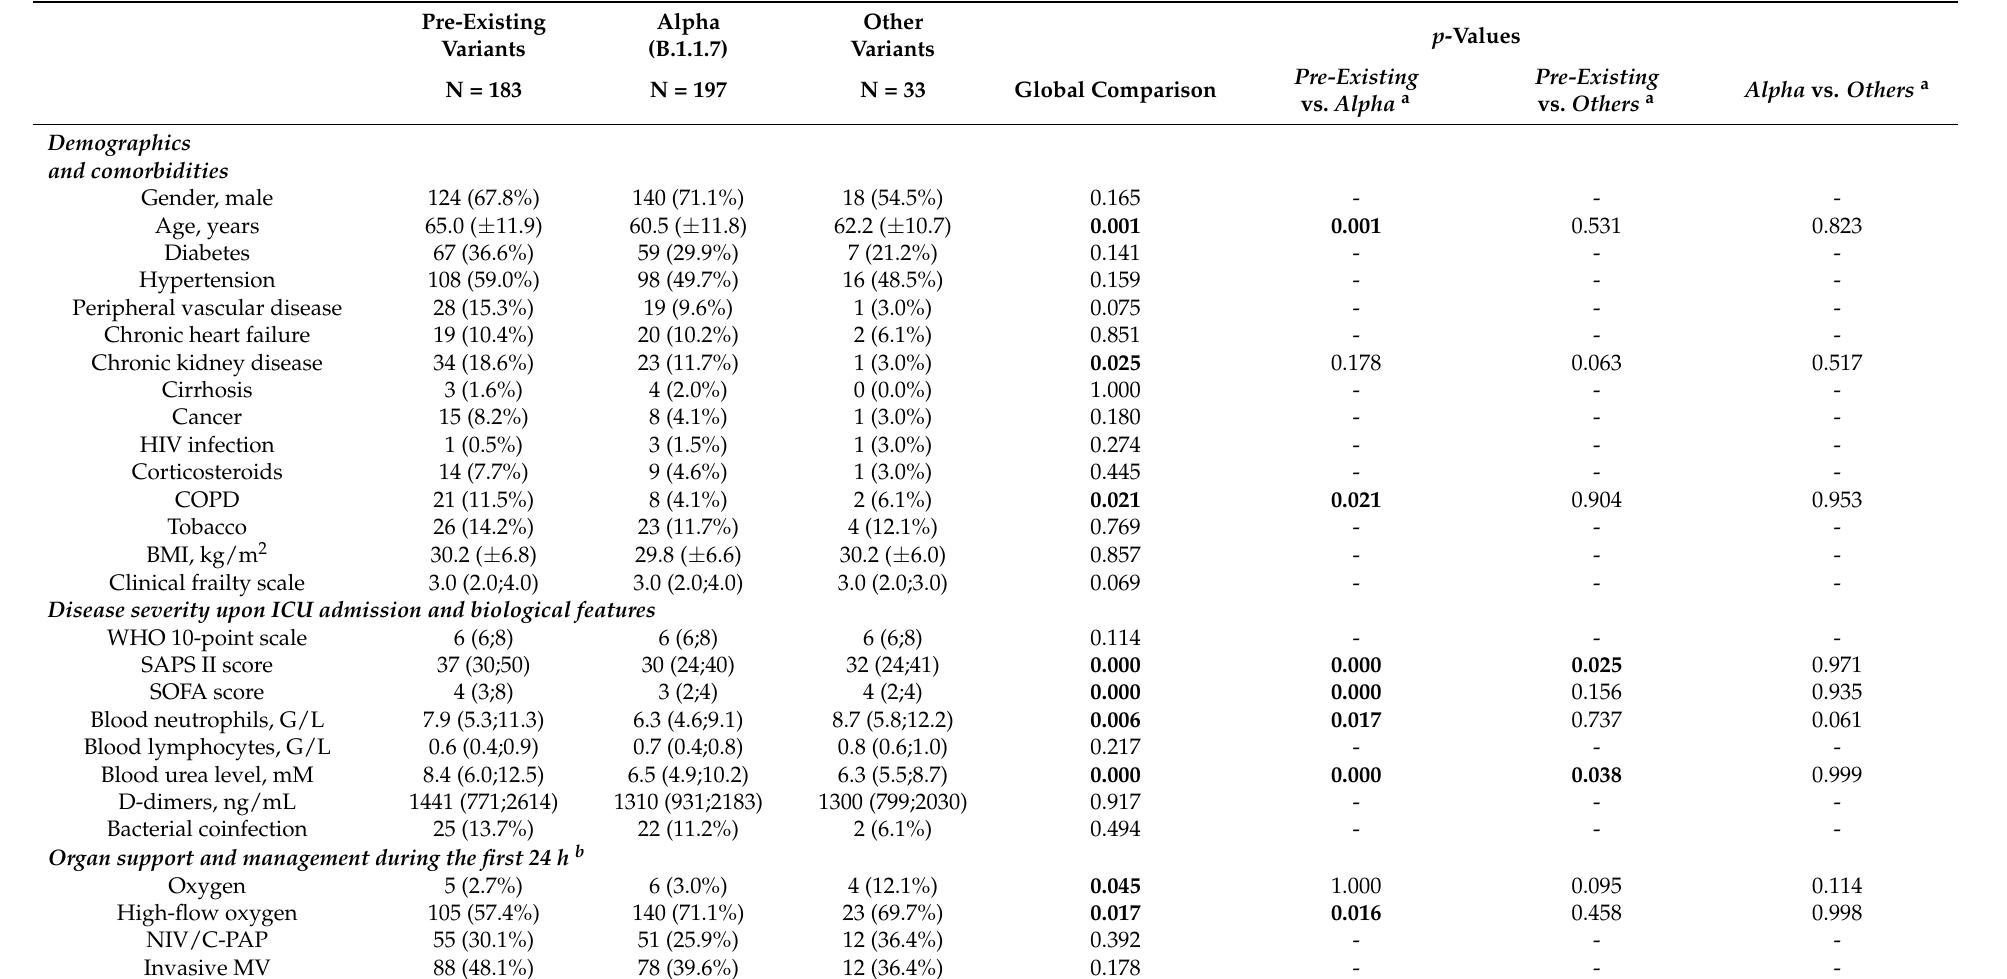
Table 1. Characteristics of patients with severe SARS-CoV-2 infection (n = 413) at the time of intensive-care-unit admission, according to SARS-CoV-2